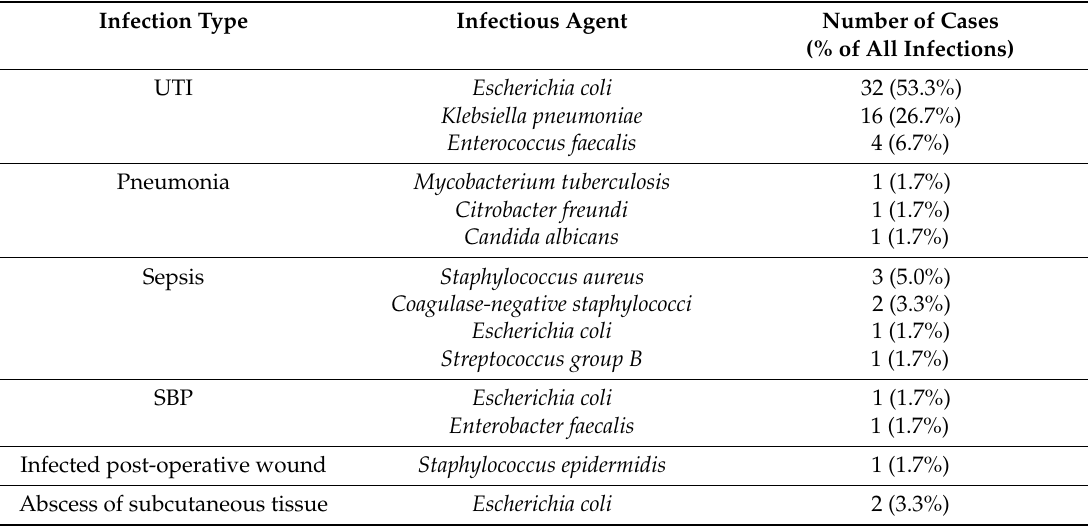
Table 2. The bacteria identified in diagnosed infections.